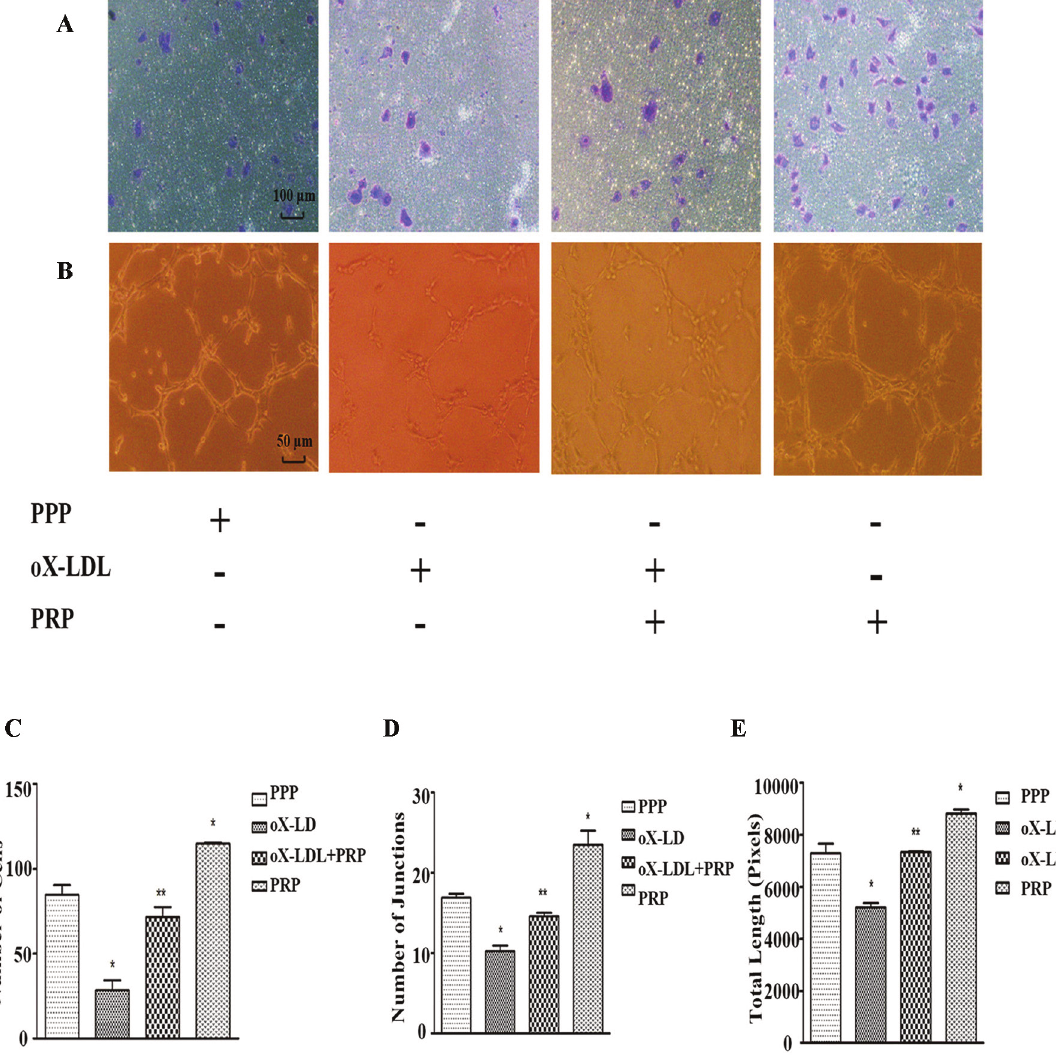
Figure 2: Capacity of migration and tube formation (mean ± SD). A: Cells that had migrated through the membrane were stained with crystal violet. B: Junctions and length of loops formed by HUVECs were calculated and analyzed. C: Number of migrated cells. D: Number of joints. E: Total length. *p<0.05 versus control; **p<0.05 versus